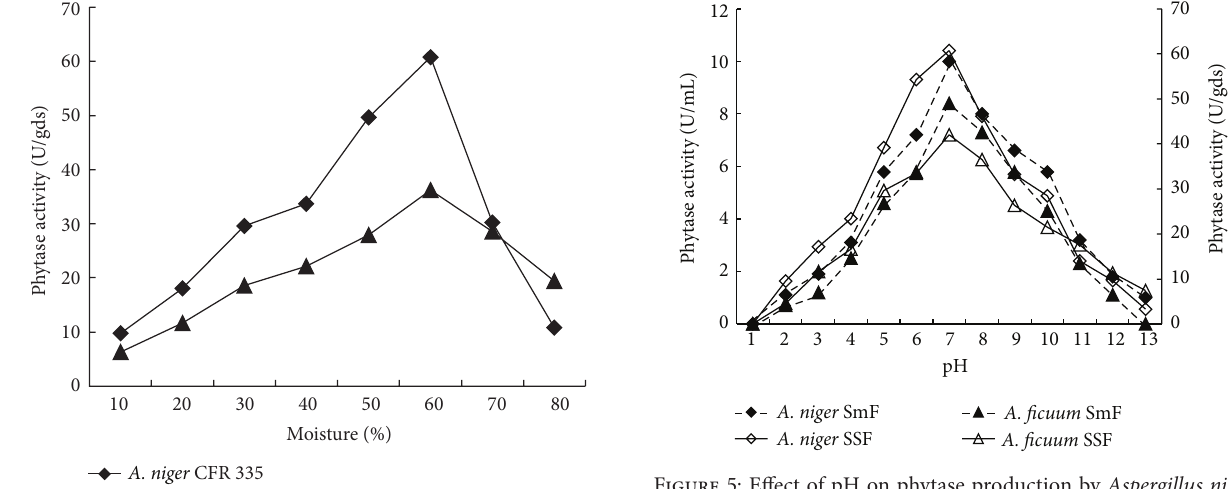
Figure 5: Effect of pH on phytase production by Aspergillus niger CFR335and Aspergillusficuum SGA01insubmergedandsolid-state